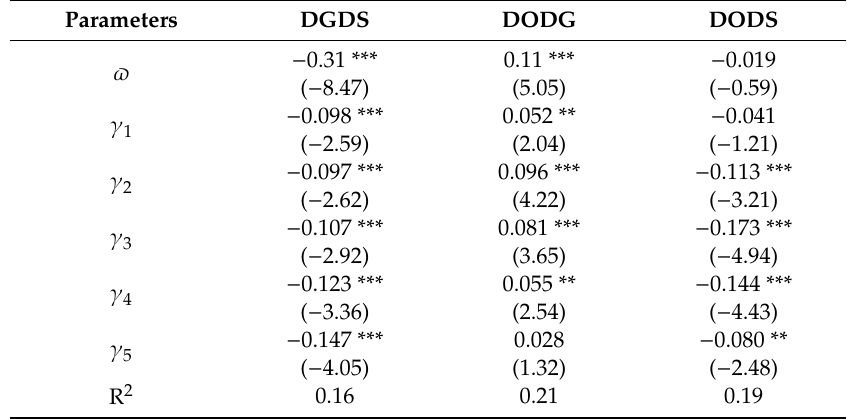
Table 4. Dynamic conditional correlations and financial crises. Sample: 2000m11–2018m10 (216 Observations). Parameters